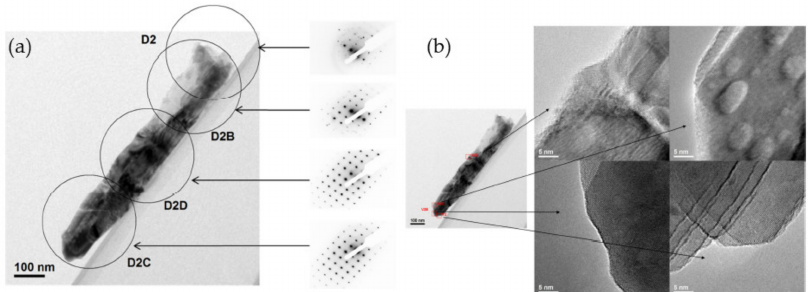
Figure 18. High-resolution TEM picture of an isolated column from a slanted columnar TiO 2 thin film annealed 2 h at 773 K; ( a ) the corresponding electron di ff raction patterns; ( b ) high-magnification pictures at various locations.